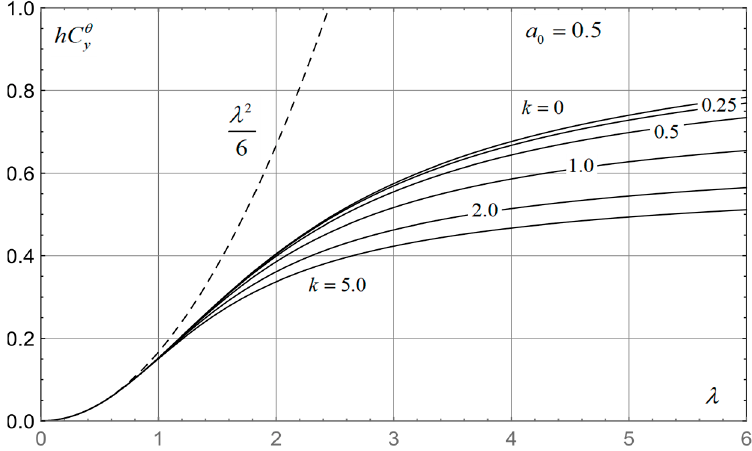
Figure 12. Derivative hC θ y for a rectangular wing in extreme ground effect versus aspect ratio for a 0 = 0.5 and different Strouhal numbers.